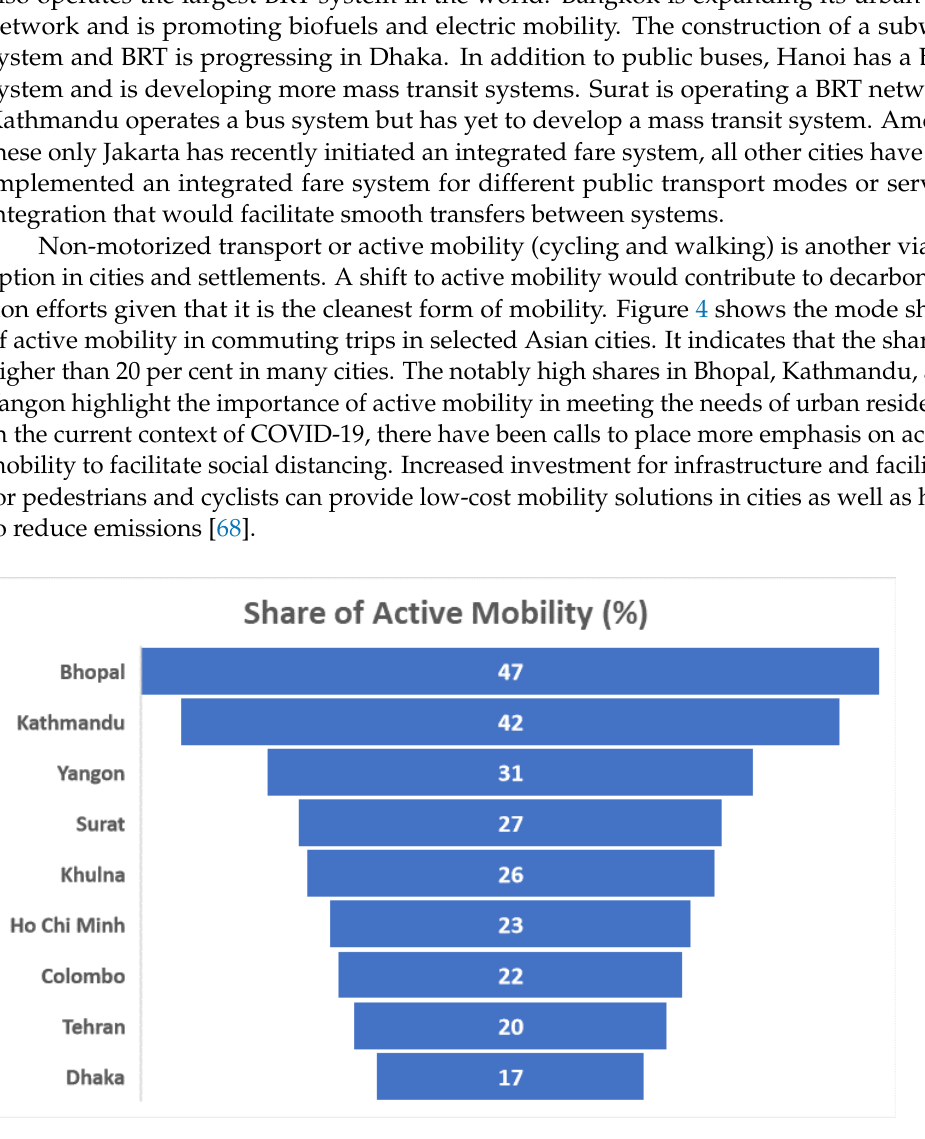
Figure 4. Mode share of active mobility in Asia. Source: Compiled from